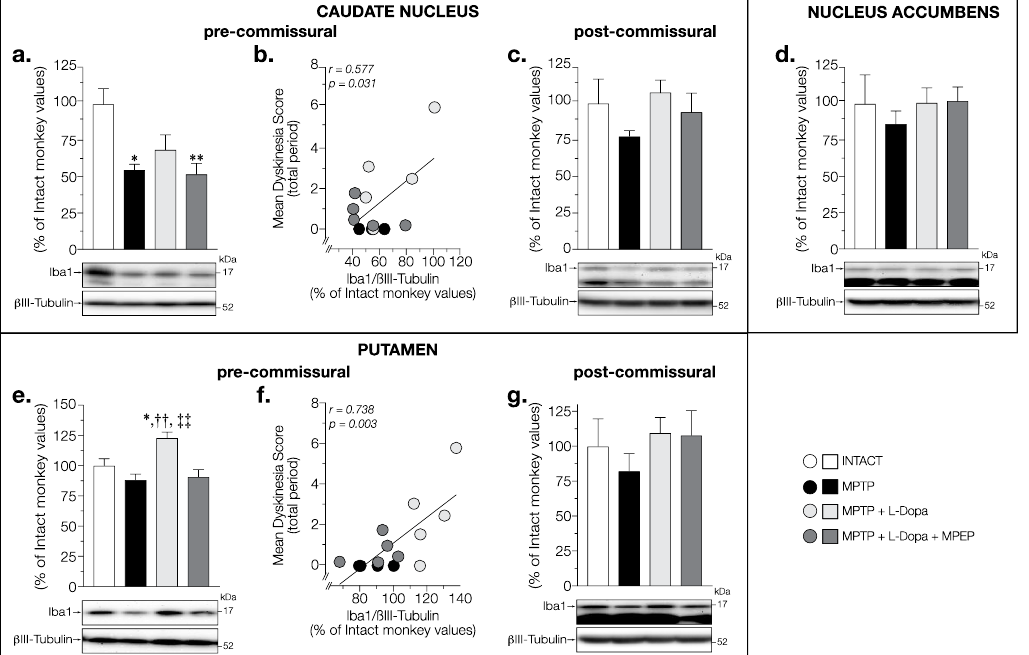
Figure 6. Western blots for Iba1 protein levels in ( a , c ) pre- and post-commissural caudate nucleus, ( d ) nucleus accumbens, and ( e , g ) pre- and post-commissural putamen of intact monkeys (control), MPTP monkeys treated with saline, L-Dopa, and L-Dopa + MPEP, and correlation between mean dyskinesia score of the MPTP monkeys treated with saline, L-Dopa, and L-Dopa + MPEP, and Iba1 levels in pre-commissural ( b ) caudate nucleus, and ( f ) putamen expressed as percentage of control (βIII -tubulin was used as internal loading control); each point represents an individual monkey. Values are means of arbitrary units expressed as percentage of control (βIII -tubulin was used as internal loading control) of 3 – 4 independent experiments ± standard error of mean of 4 – 5 monkeys per group. * p < 0.05 and ** p < 0.01 vs. INTACT; †† p < 0.01 vs. MPTP; ‡‡ p < 0.01 vs. MPTP + L-Dopa + MPEP. In the pre-commissural putamen, Iba1 levels showed significant changes (F (3,14) =